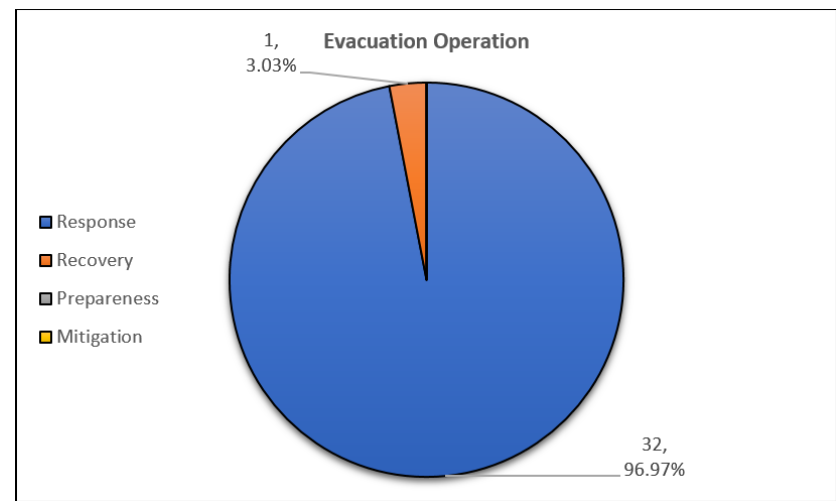
Figure 8. Breakdown of VRP Evacuation Operation based on DM Phase.